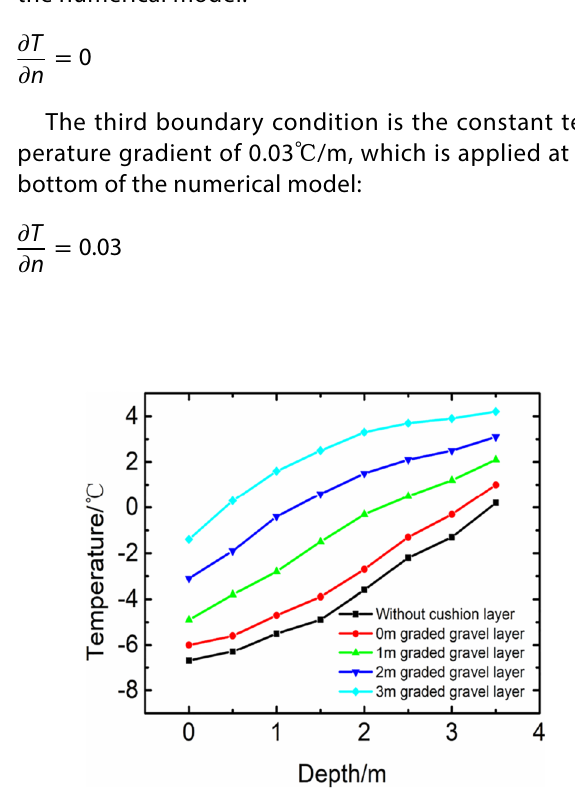
Fig. 2 30-year temperature